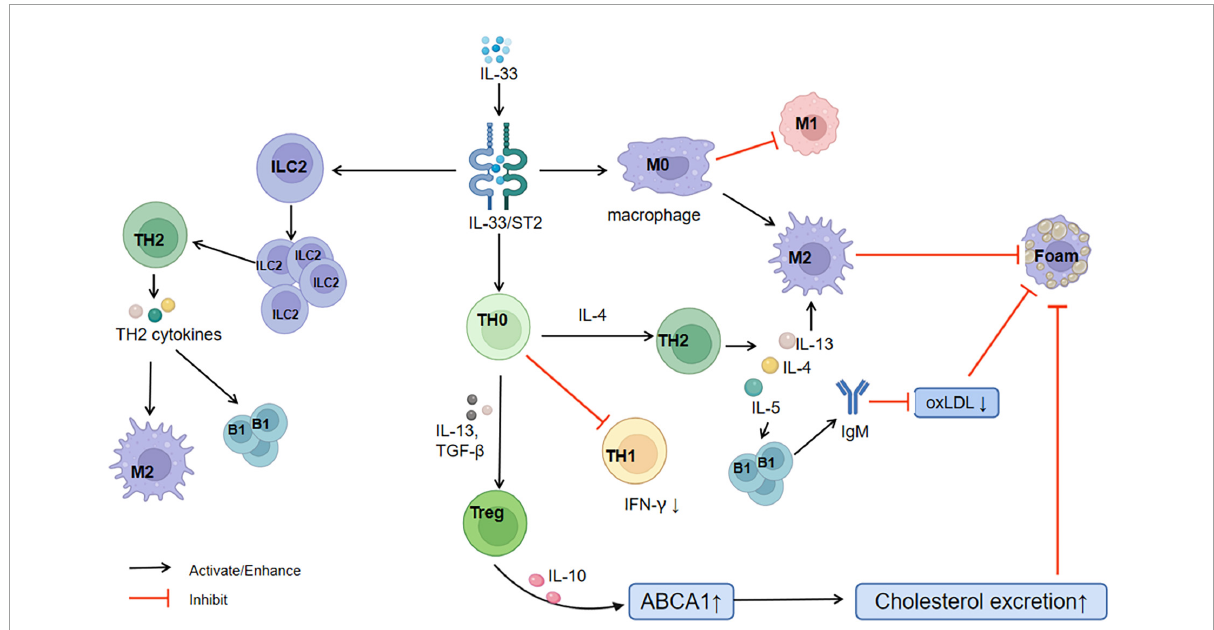
FIGURE4 Relationship between IL-33/ST2 and CAD. CAD, coronary artery disease; M1, M1 phenotype of macrophages; M2, M2 phenotype of macrophages; TH1, T-helper 1; TH2, T-helper 2; ILC2, type 2 innate lymphoid cells; B1: B1 cells; Treg, regulatory T cells; Foam, foam cells; oxLDL, oxidized low-density lipoprotein; ABCA1, ATP-binding cassette transporter